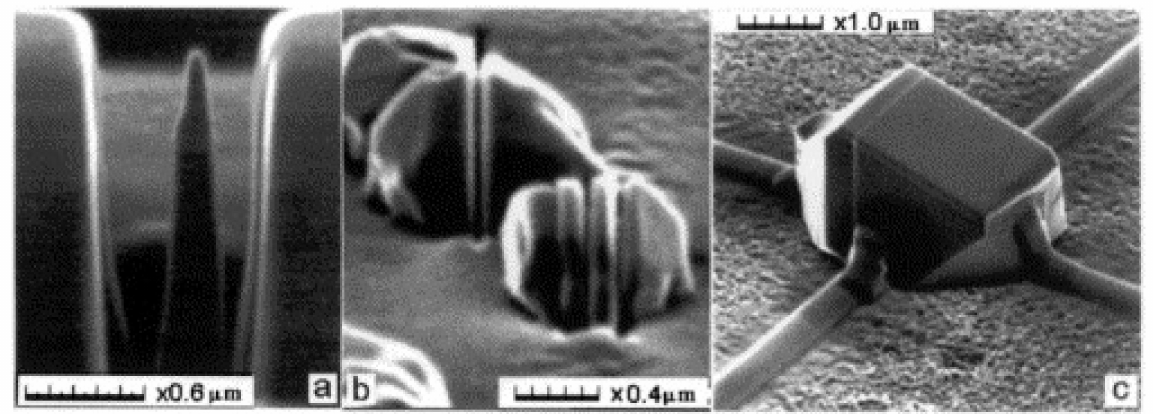
Figure 14. Structure fabricated using FIB; ( a ) nanotip in 1-mm thick ta-C film, ( b ) nanoscale trenches in diamond microcrystallites, and ( c ) tungsten contacts. Reprinted with permission from [143]. Copyright 2001, Elsevier.